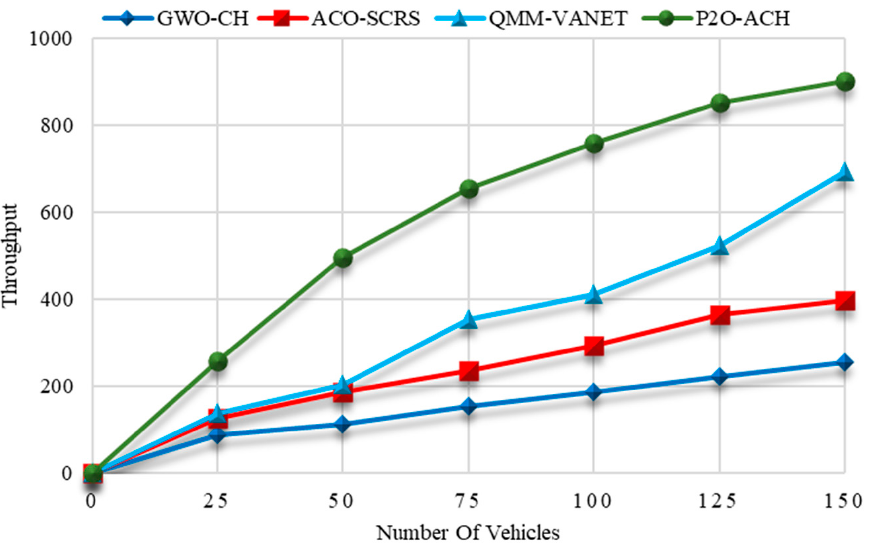
Figure 8. Routing Overhead Calculation.